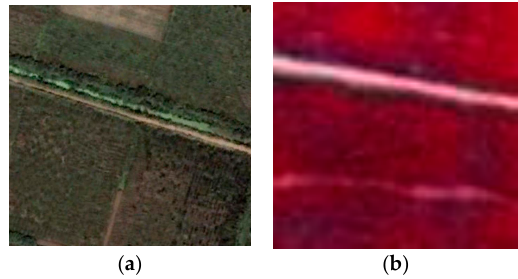
Figure 6. Farmland in: ( a ) optical image (red-green-blue); and ( b ) remote sensing image (green–red–infrared).